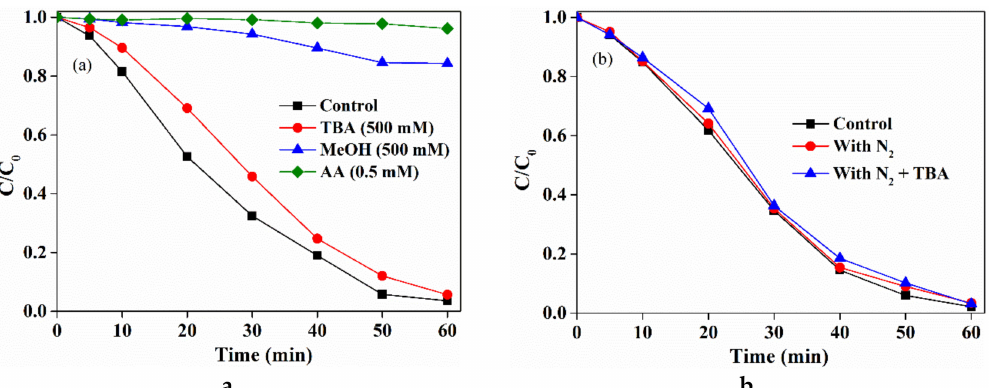
Figure 4. ( a ) E ff ect of ascorbic acid (AA), tert -butanol (TBA) and MeOH, and ( b ) Dissolved oxygen (DO) on the degradation of SMX in the LaCoO 3 / PAA system. LaCoO 3 = 20 mg / L, SMX = 50 µ M, PAA = 660 µ M, pH 7, 25 ◦ C.